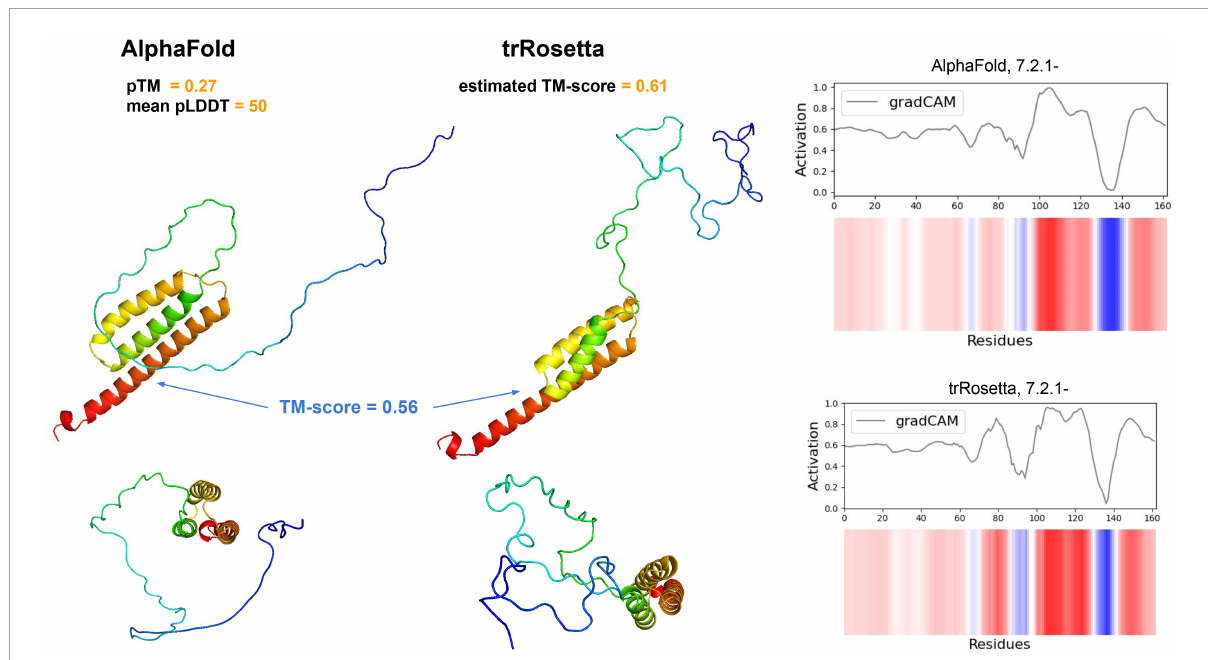
FIGURE5 Alphafold (left) and trRosetta models (middle) of our putative reductase gene (EC 7.2.1.-). Each structure is shown from two different perspectives (lower and upper panels). The TM-score between both structures (excluding disordered tails) is depicted in blue. For both the AlphaFold and trRosetta predictions, the model quality measures are shown (see Yang et al., 2020; Jumper et al., 2021 for details). On the right panel, the DeepFRI activation map across residues is